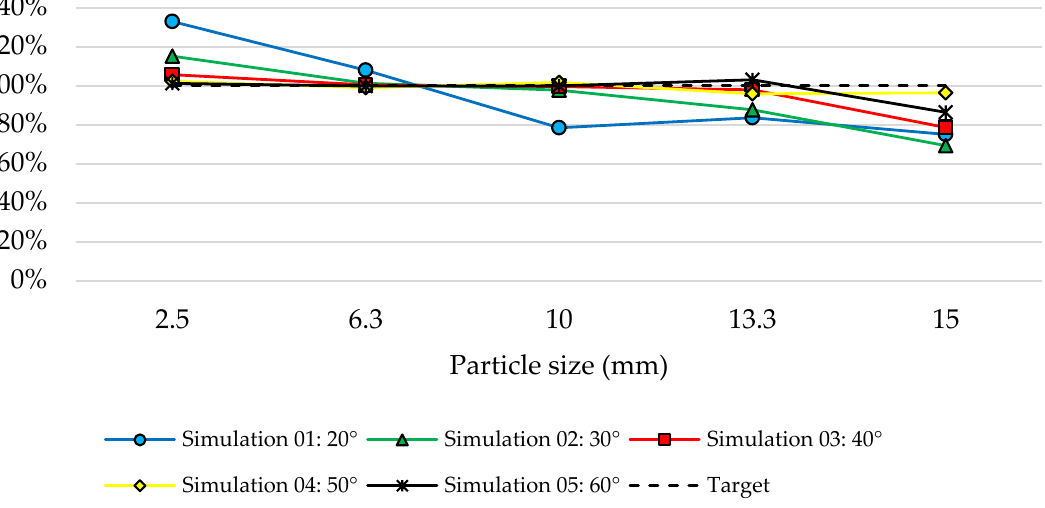
Figure 9. Extraction in cross-stream cutter as function of the cutter angle.